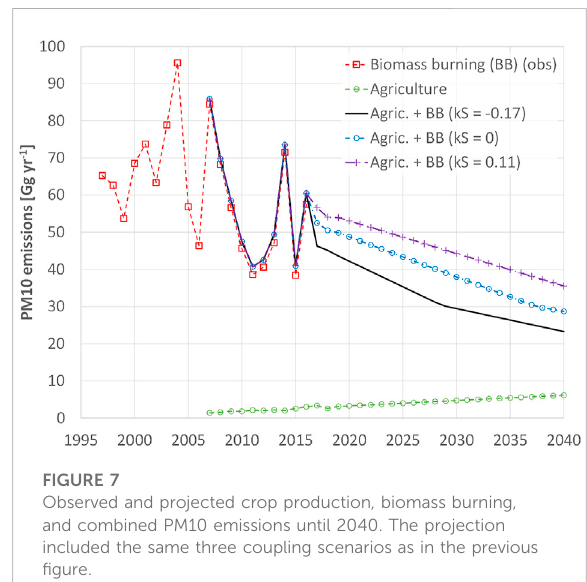
FIGURE 7 Observed and projected crop production, biomass burning, and combined PM10 emissions until 2040. The projection included the same three coupling scenarios as in the previous fi